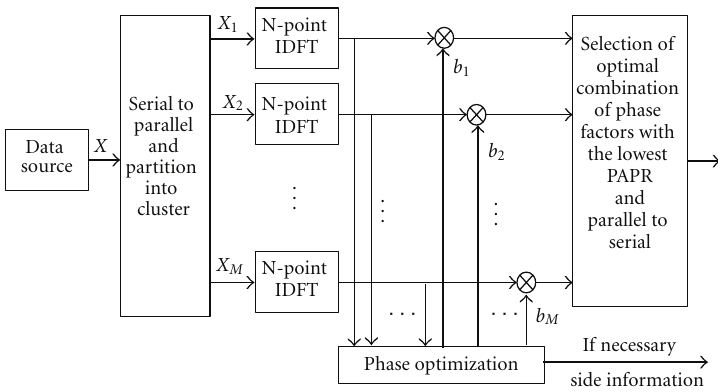
Figure 1: PTS techniques block